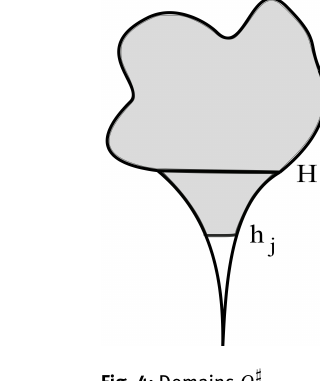
Fig. 4: Domains Ω (cid:93)